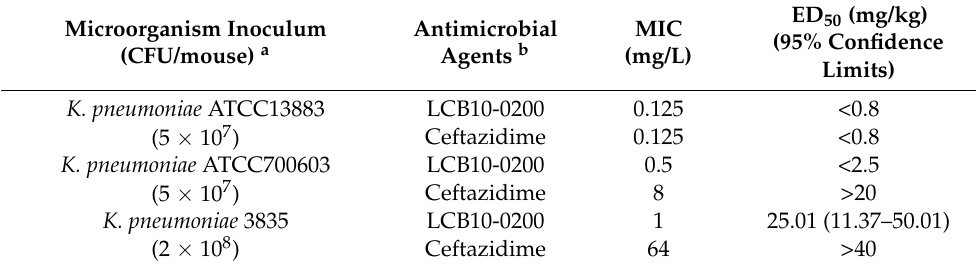
Table 3. In vivo activities of LCB10-0200 against systemic infection model in mice. Microorganism Inoculum (CFU/mouse) a